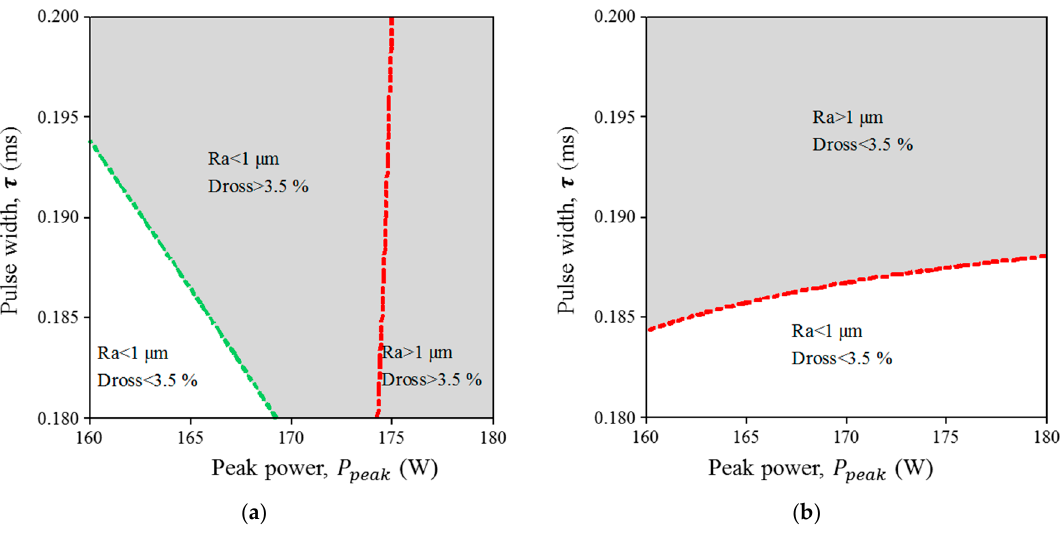
Figure 5. Influence of pulse width and peak power on surface roughness and back wall dross. ( a ) Miniature tube A: Annealed and 110 μ m thickness (fixed parameters: pulse frequency, 700 Hz; cutting speed, 250 mm/min; gas pressure, 10.34 bar). ( b ) Miniature tube B: Hard drawn and 160 μ m thickness (fixed parameters: pulse frequency, 875 Hz; cutting speed, 750 mm/min; gas pressure, 12.06 bar).